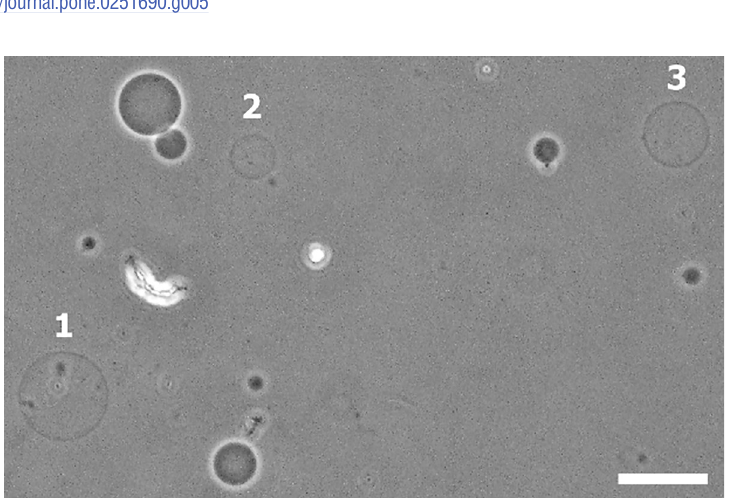
Fig 6. Phase contrast microscopic image of DOPG/DOPC/chol (46/39/15)-GUVs under the influence of the osmolarity difference between the inside and outside of GUVs, Δ C 0 = 29 mOsm/L. Large osmotic pressure-induced leakage of sucrose due to the pore formation in the membranes of GUVs. The GUVs labeled by 1, 2 and 3 leaked out sucrose from their inside. The scale bar corresponds to a length of 50 μ m.